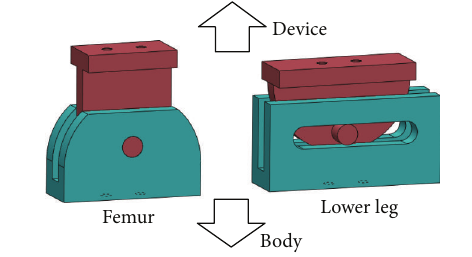
Figure 12: Hinge parts for